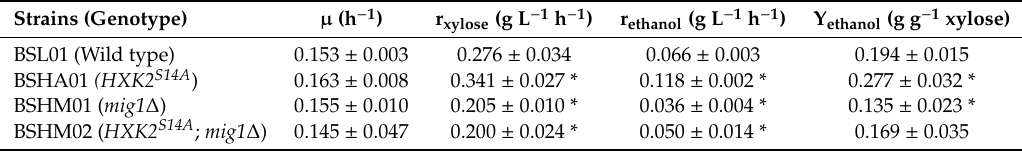
Table 2. Xylose fermentation characteristics of the parental and engineered yeast